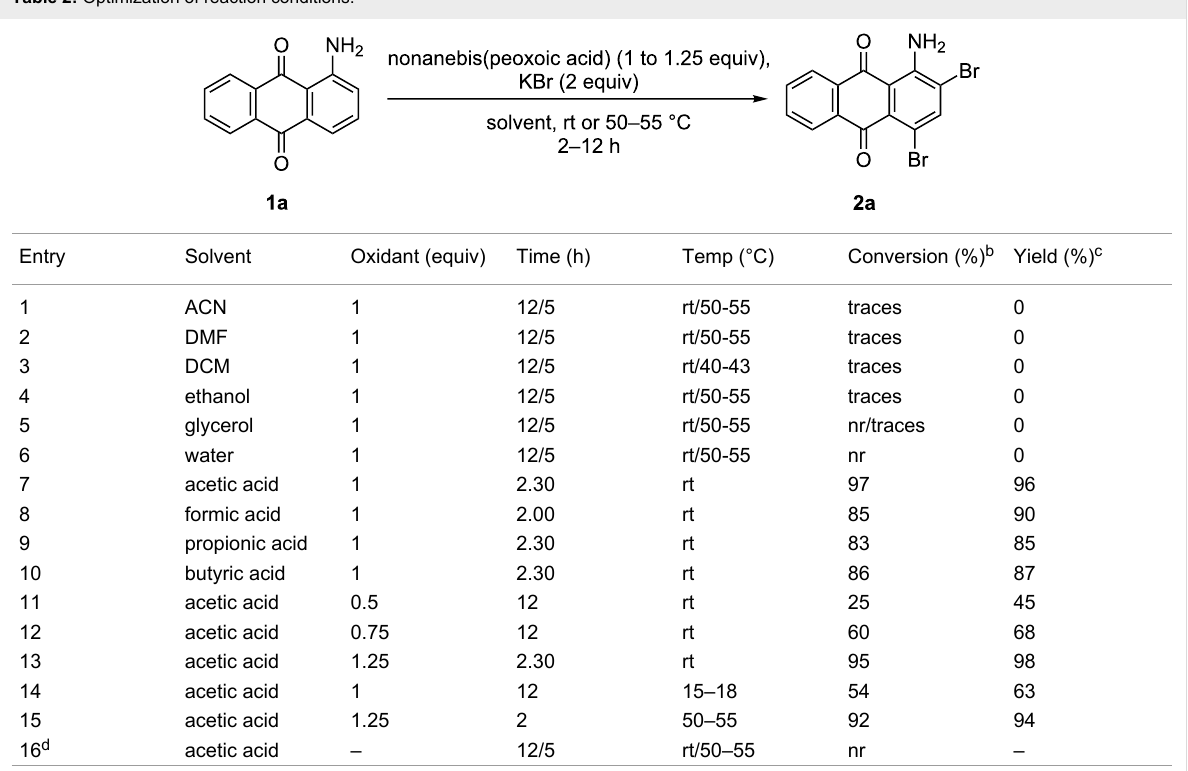
Table 2: Optimization of reaction conditions. a